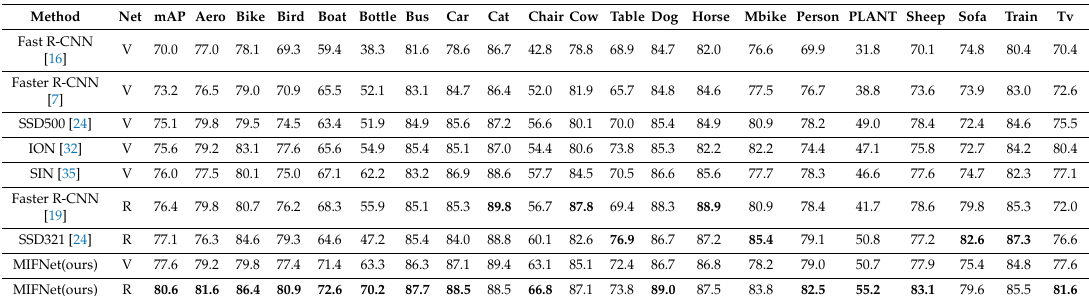
Table 2. Detection results on PASCAL VOC 2007 test. Train set: 07 trainval + 12 trainval. “V” and “R” denote the model uses VGG-16 and Resnet-101 as backbone networks, respectively. The bold characters represent the best result for each column.